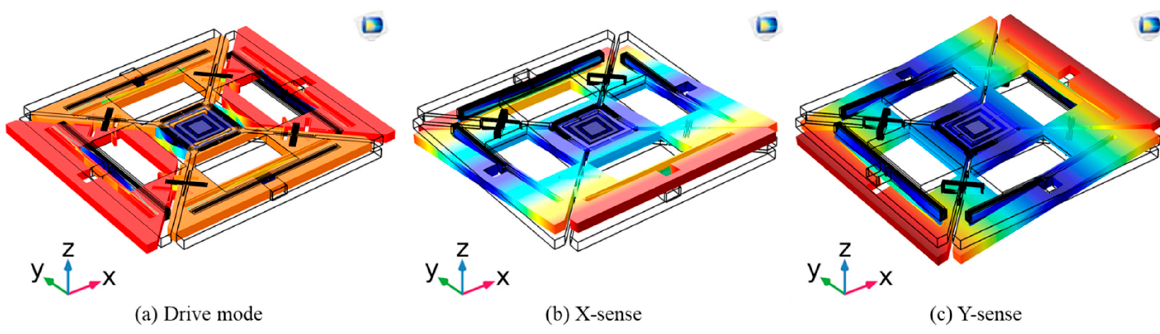
Figure 2. Resonant Modes of the Designed MEMS Gyroscope. ( a )Drive Mode; ( b ) X-Sense; ( c ) Y-Sense.